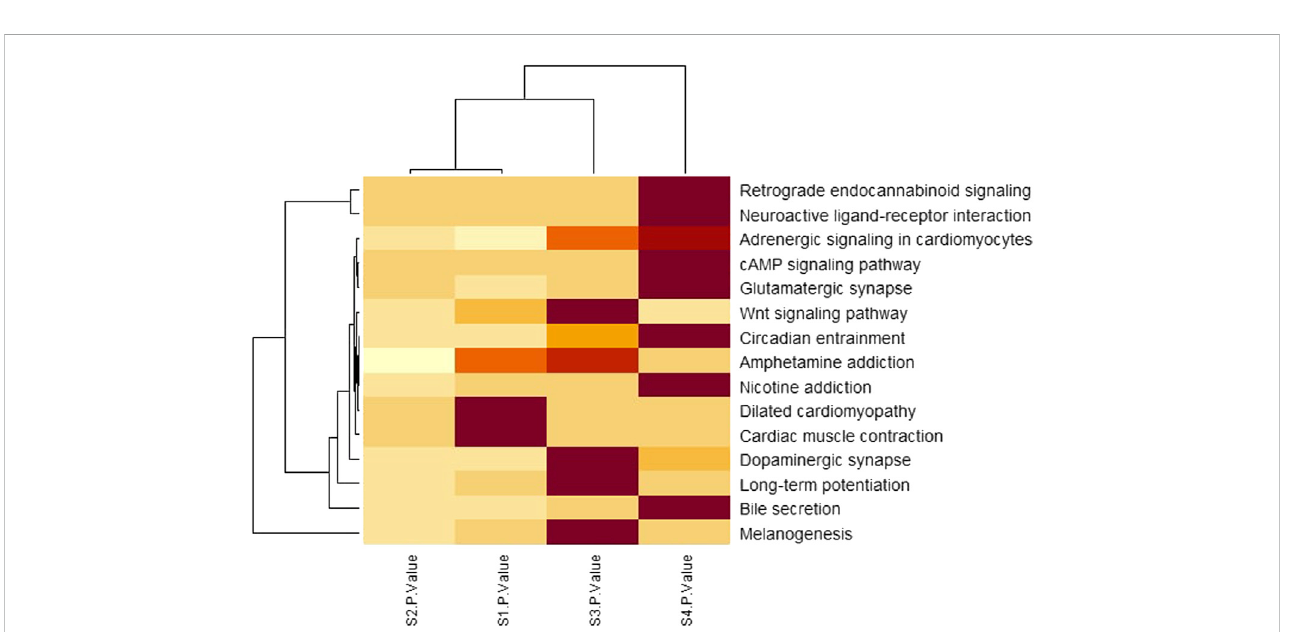
FIGURE 5 Pathway analysis by clustered heatmap analysis of four stages where pathways were selected by the KEGG pathway enrichment analysis. The functional components identi fi ed from the KEGG pathway enrichment analysis are presented row-wise (right side) and each stage is presented column-wise (bottom). The color intensities indicate the enrichment score of each KEGG pathway with a color gradient that moves from light yellow to maroon. The dendrogram indicates the similarity between pathways as well as